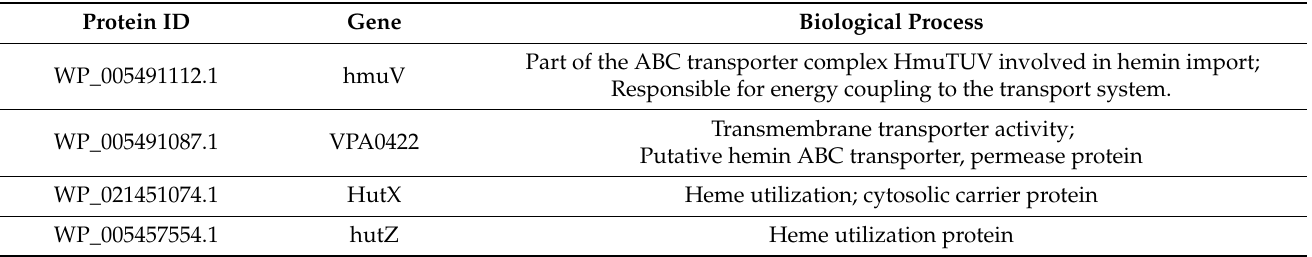
Table 3. Proteins involved with iron metabolism. In the first column, IDs from the proteins found on the PAI2 of chromosome 2 of V. parahaemolyticus , followed by the encoding gene and the biological process involved according to the UniProt